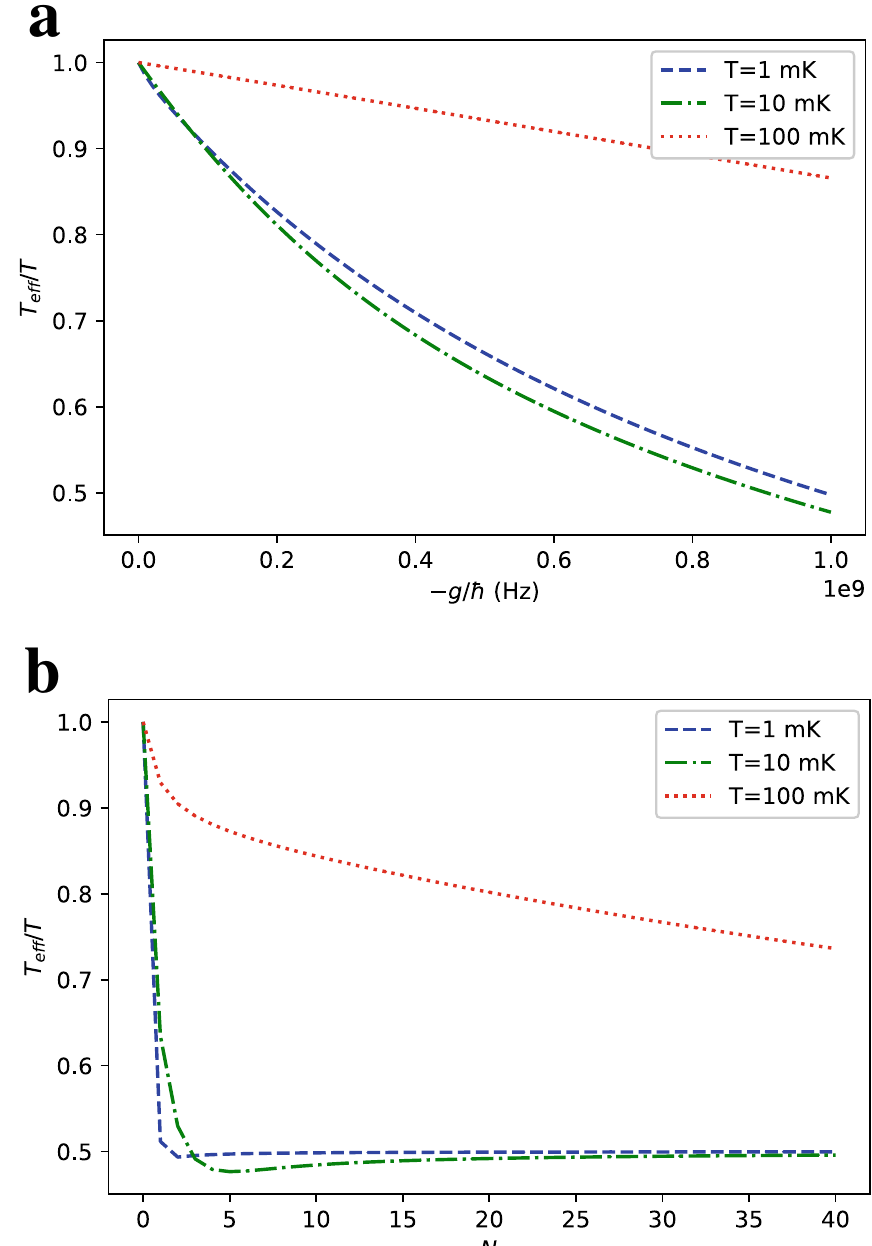
Figure 5. Ratio of the effective temperature T eff = 1 / k B β eff,whole of the whole spin-star system after turning off its Ising interactions defined in Eq. (18) to the environment temperature T as a function of ( a ) interaction strength g with N = 6 and ( b ) number of ancilla N qubits with g = − h . We take h = 1